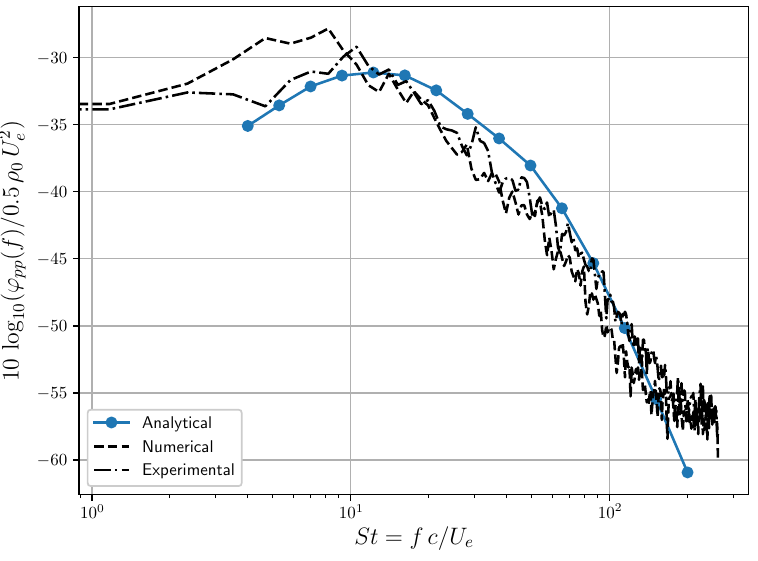
Figure 16. Prediction of the wall-pressure PSD at 2% of the chord upstream of the trailing edge, compared with measurement and LES